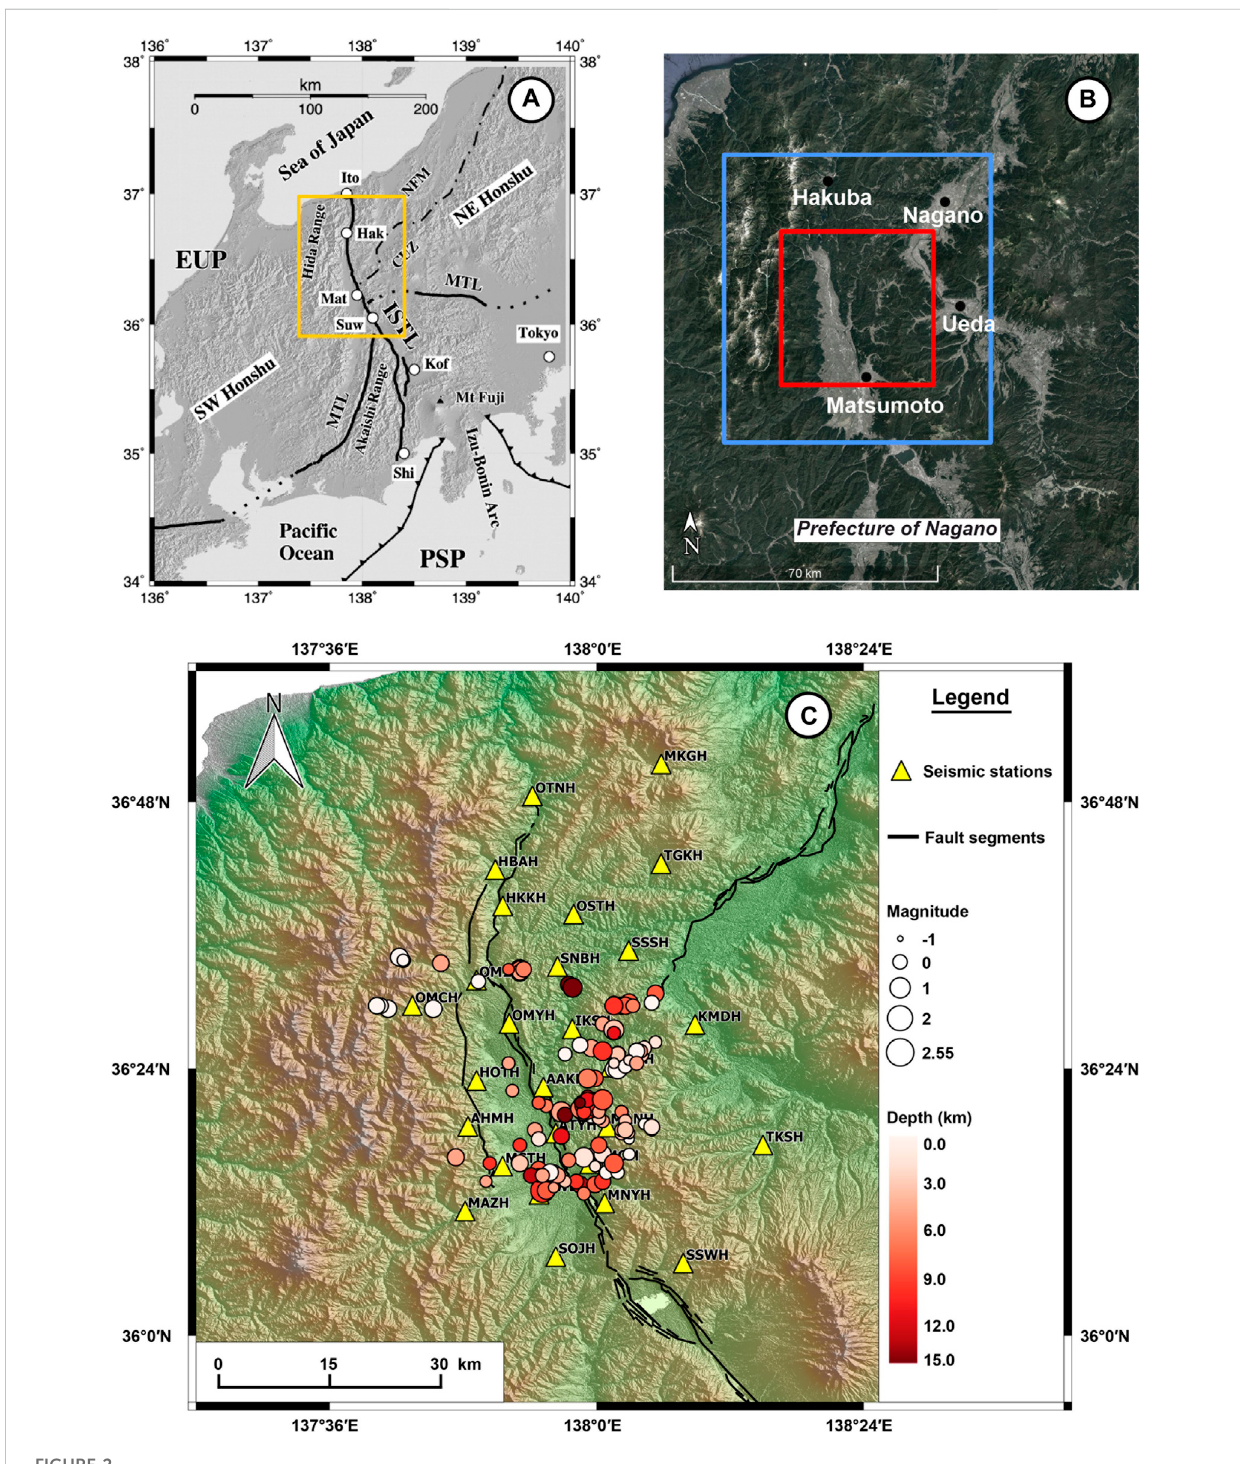
FIGURE 2 Location map of the study area (A, B) and epicentralmap of the JMA earthquakesused as reference catalog in thisstudy (C) . (A) Location of the area of interest, Nagano prefecture, along the ISTL line. The yellow contoured area is the location of the area plotted in the (B) and (C) panels (modi fi ed after Panayotopoulos et al., 2016). (B) The blue rectangle (70 km × 75 km) shows the location of the volumetric grid of potential hypocenters investigated in this work, the red rectangle delineates the target area (40 km × 40 km) used for the fi nal selection of events. (C) Circles depict micro-seismicity recordedbytheJapaneseseismographicnetworkHi-net(yellowtriangles)duringMay2011occurredwithinthetargetarea[redsquarein (B) ].Thisareais the region best covered by the selected seismic network stations. The earthquake locations are from the JMA catalog. The sizes and colors of the circles are coded according to the magnitude and depth of the earthquakes,